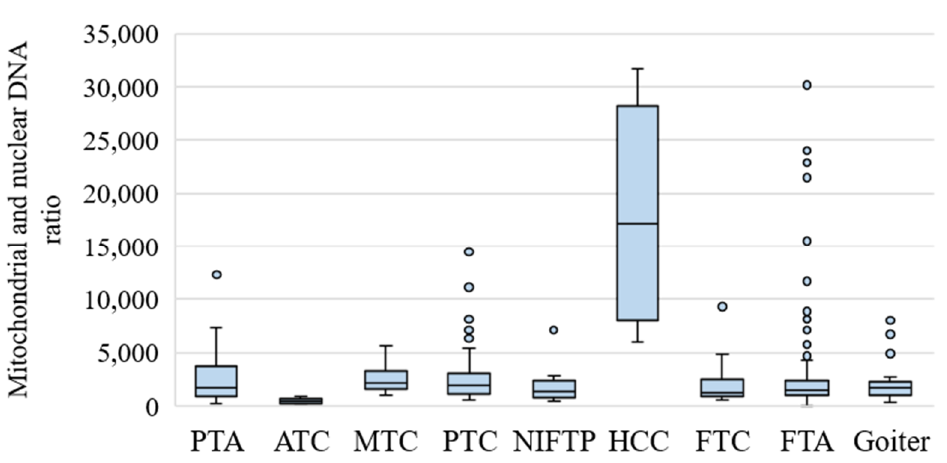
Figure 4. The mtDNA/nDNA ratio in goiters and thyroid/parathyroid tumors. The figure presents the median value, upper and lower quartiles, a nonoutlier range, and outliers (circles). Some samples with a large amount of mtDNA (above the cutoff set by us) were iden- tified among goiters, PTCs, and especially FTAs. It was noted in the histological report that nine cases of FTA were oncocytic; among them, in eight cases (88.9%), the mtDNA/nDNA value exceeded the cutoff specified in our classifier. In five other samples (4.9%) in which mtDNA/nDNA exceeded the cutoff (one of them was identified as HCC